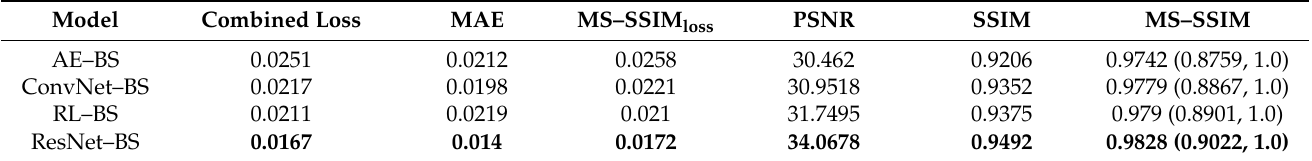
Table 2. Performance achieved by the proposed bone suppression models using the cross-institutional NIH–CC–DES test set. Data in parenthesis are 95% CI for the MS–SSIM values measured as the “Wilson” score interval. Combined loss = 0.16 * MAE + 0.84 * MS–SSIM loss . The best performances are denoted by bold numerical values in the corresponding columns. The ResNet–BS model statistically significantly outperformed the AE–BS model in all categories ( p < 0.05), and the ConvNet–BS, and RL–BS models for the PSNR metric ( p < 0.05). For other metrics, the ResNet–BS model demonstrated superior performance than the CNN–BS, and RL–BS